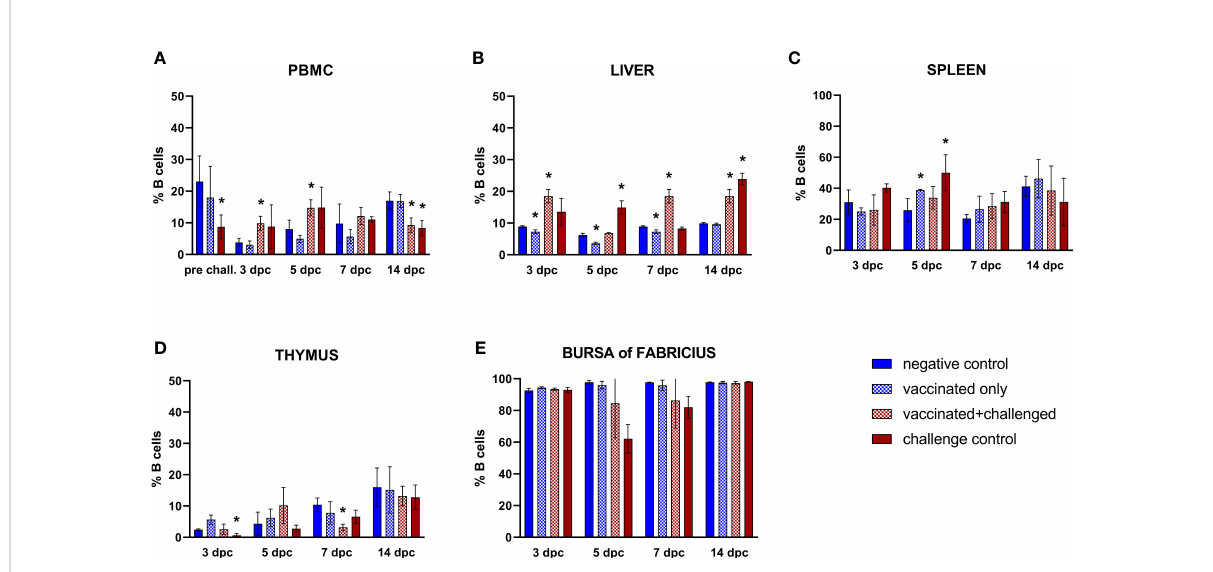
FIGURE 3 Relative number of B cells within total CD45 + cells measured via FCM for each experimental group throughout the study in PBMC (A) , liver (B) , spleen (C) , thymus (D) , and bursa of Fabricius (E) . Data for the two vaccinated groups (vaccinated only and vaccinated+challenged) are merged to determine values in PBMCs pre-challenge. Asterisks represent signi fi cant difference compared to the negative control at each time point ( p ≤ 0.05).